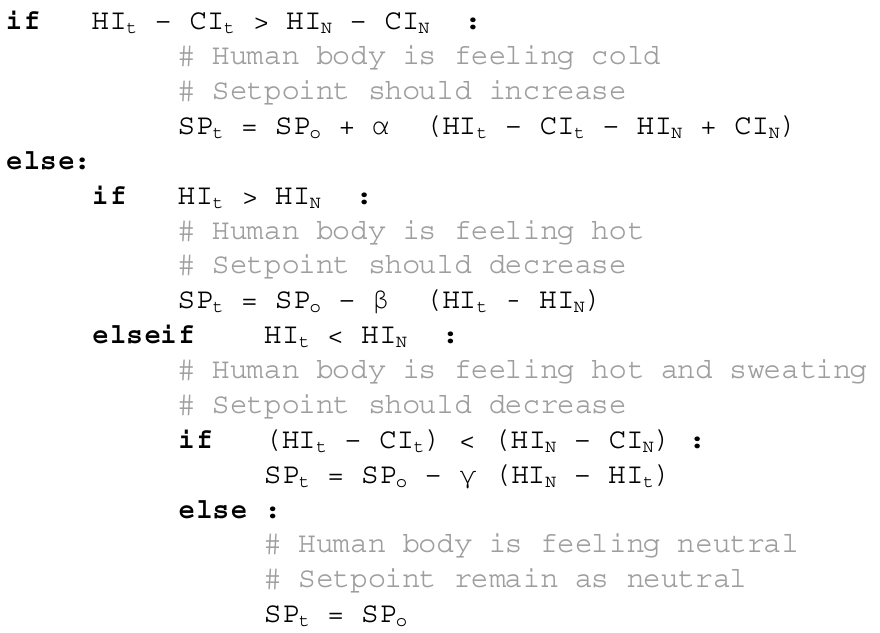
Figure 2. Algorithm pseudocode to infer human body comfort and provide setpoint (SP) adjustments. t refers to any given time. N refers to neutral-condition measurements of the human body. Coefficients α , β , and γ are weights that help the HVAC system respond effectively to individual comfort requirements. SP (cid:2868) is the steady-state optimal zone setpoint.